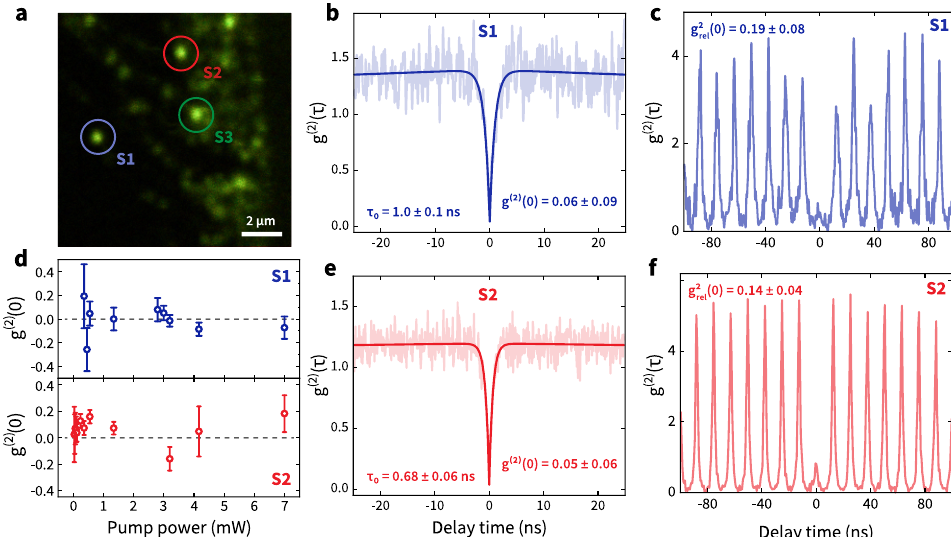
Figure 2. ( a ) Photoluminescence scanning image obtained under 532-nm CW laser illumination. Circles indicate quantum emitters. Autocorrelation functions g ( 2 ) ( τ ) for the emitters S1 ( b , c ) and S2 ( e , f ) circled in ( a ) at ZPL emission under 532-nm CW and pulsed (80 MHz) 545-nm laser excitation. The absolute g ( 2 ) ( 0 ) values are given with IRF correction. Solid curves are a model fit as discussed in the text; ( d ) dependencies of extracted corrected g ( 2 ) ( 0 ) values for S1 (top) and S2 (bottom) on pump power at 532-nm